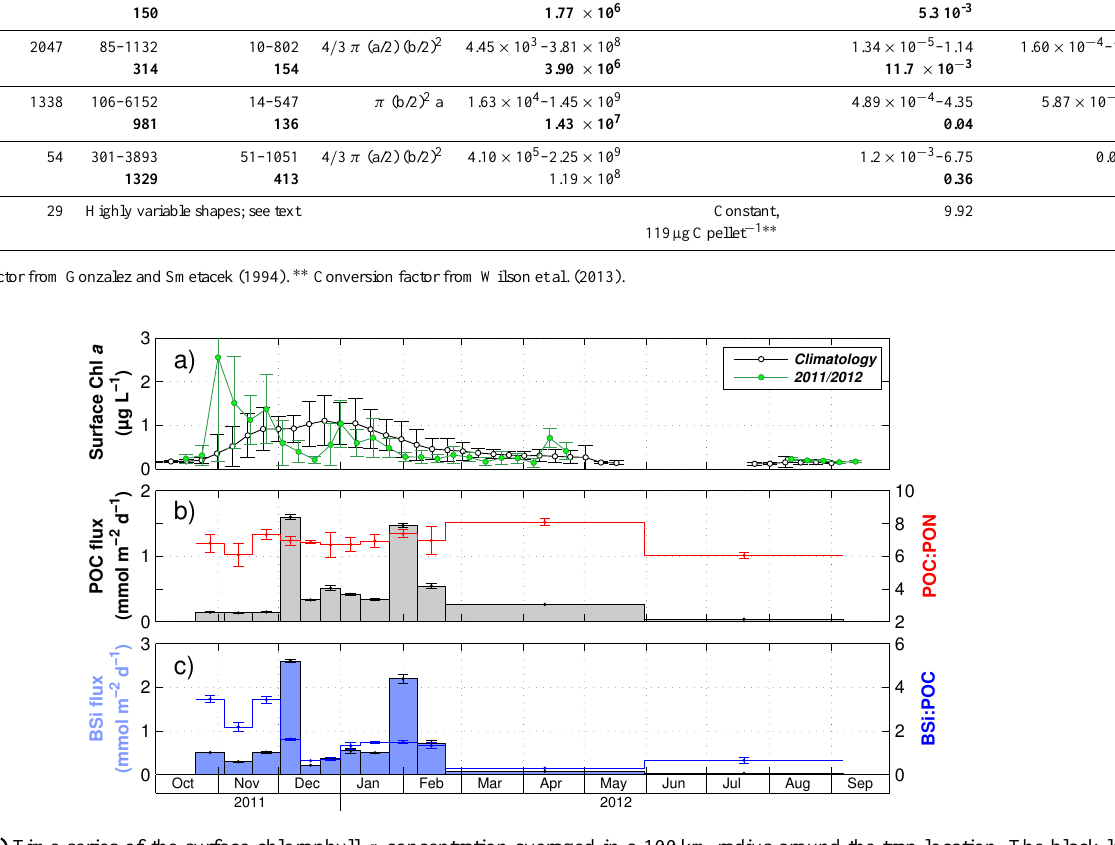
Figure 1. (a) Time series of the surface chlorophyll a concentration averaged in a 100km radius around the trap location. The black line represents the climatology calculated for the period 1997/2013, whilst the green line corresponds to the sediment trap deployment period (2011/2012). (b) POC fluxes (grey bars) and C/N molar ratio (red line) of the exported material, (c) BSi flux (light-blue bars) and BSi:POC ratio (blue line). Error bars are standard deviations on